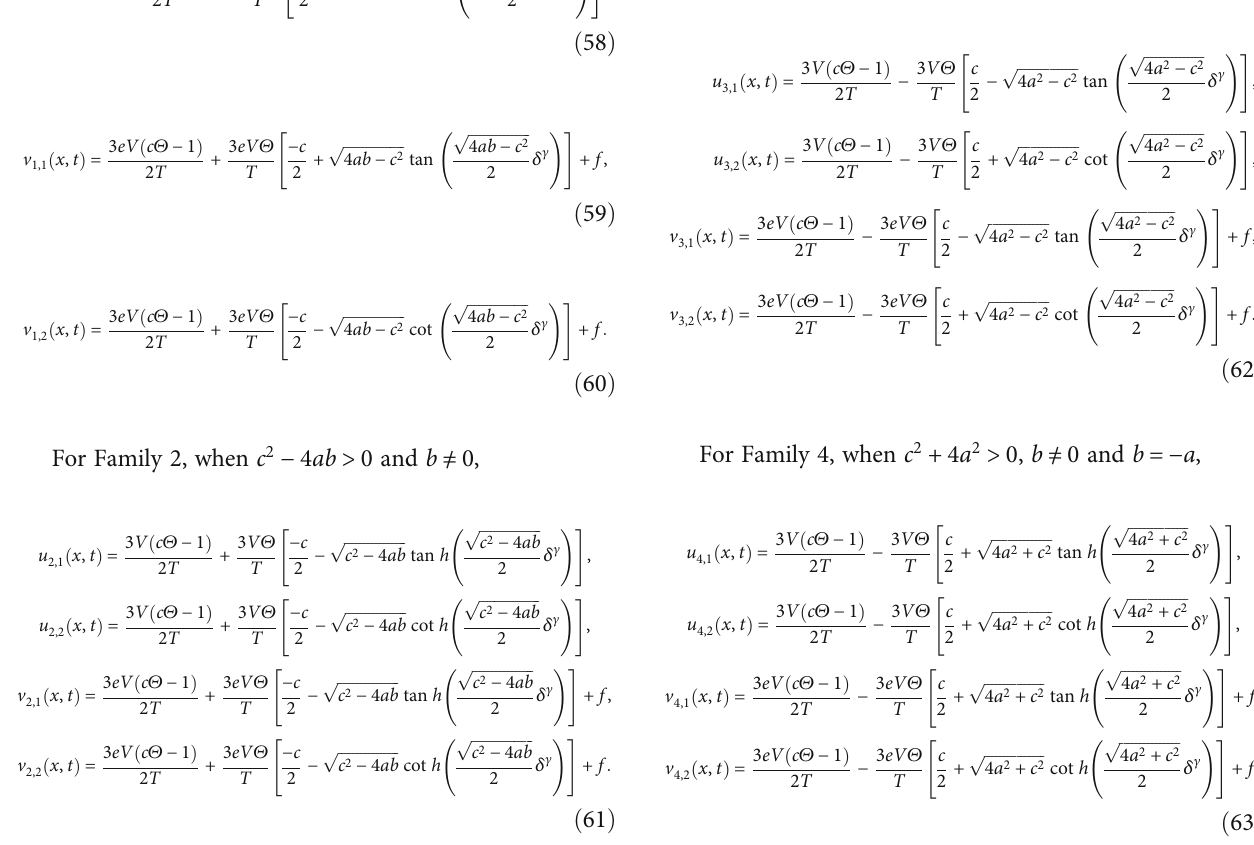
= 1 , T = 2 , V = 1 , c = 3 , a = 1 , b = 1 , and γ = 0 : 5,0 : 7,0 : 9 for the solution j u 1 ð x , t Þ with distinct values of γ 5,1